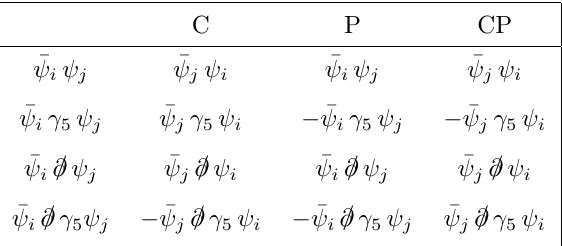
Table 4 . Results of the application of the symmetries C, P and CP to the terms in the left column. so that eq. (B.6)